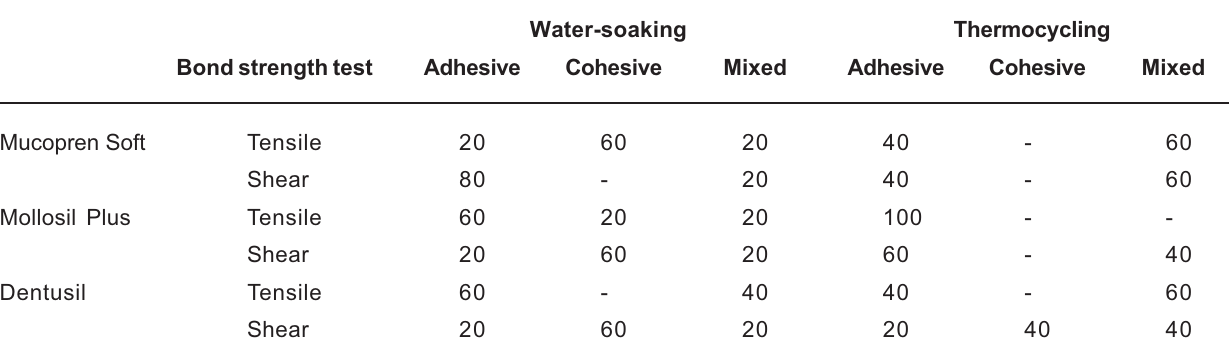
n = 10 specimens per experimental condition. TABLE 4- Failure mode frequency (%) after